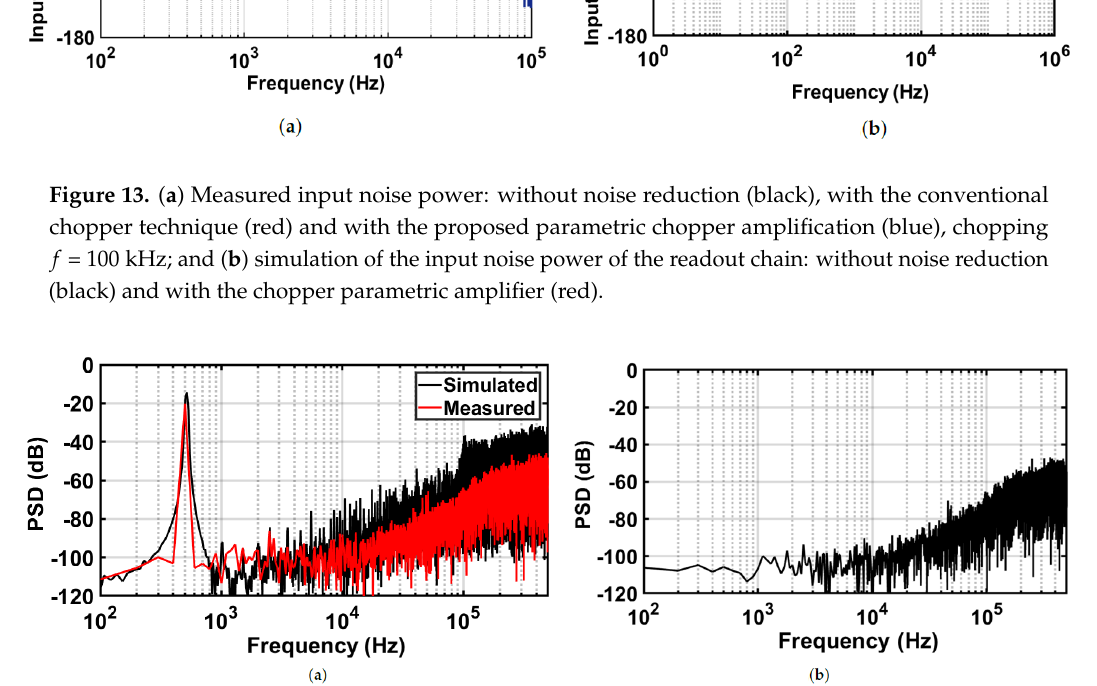
Figure 14. Simulated and measured output signal PSD of the incremental sigma-delta converter tested with an input sinusoidal tone at 500 Hz and sampling rate 1 MHz ( a ); and noise PSD measured with shorted input to ground ( b